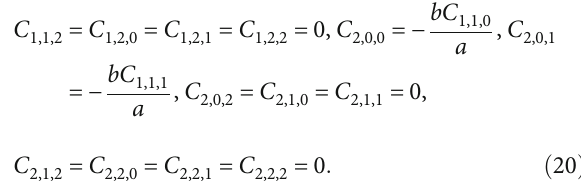
= 6, C = 6, C = 8, C = 10 0 , 0 , 1 0 , 1 , 1 1 , 0 , 0 1 , 0 , 1